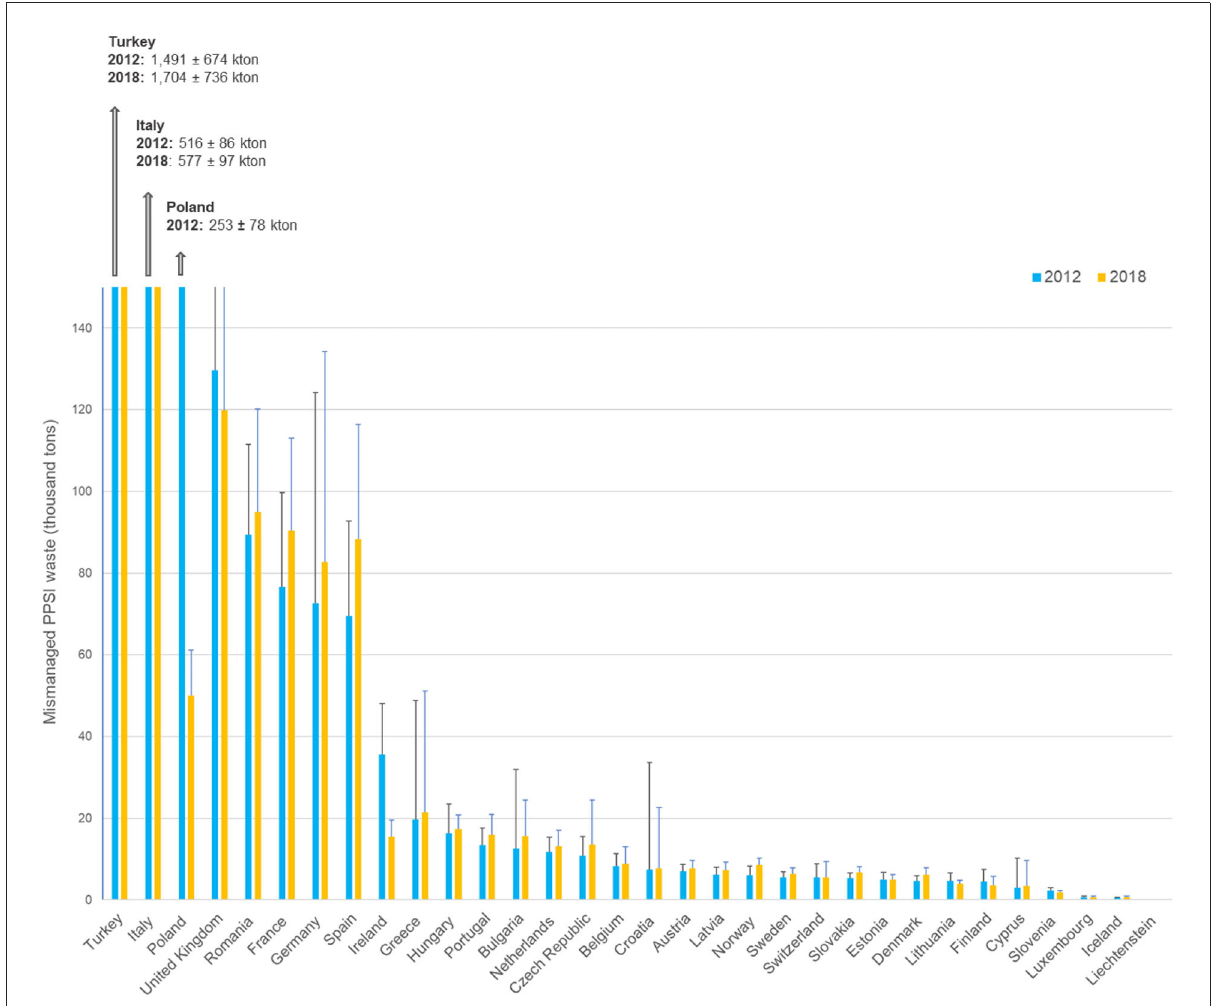
FIGURE5 Total amount of mismanaged PPSI waste (thousand tons, kton) estimated for 2012 (blue bars) and 2018 (yellow bars) in the EU-27 plus Iceland, Liechtenstein, Norway, Switzerland, Turkey, and the UK. Uncertainties are represented in the bars. Note the difference in the scale for Turkey, Italy, and Poland. PPSI, plastic packaging and small non-packaging plastic